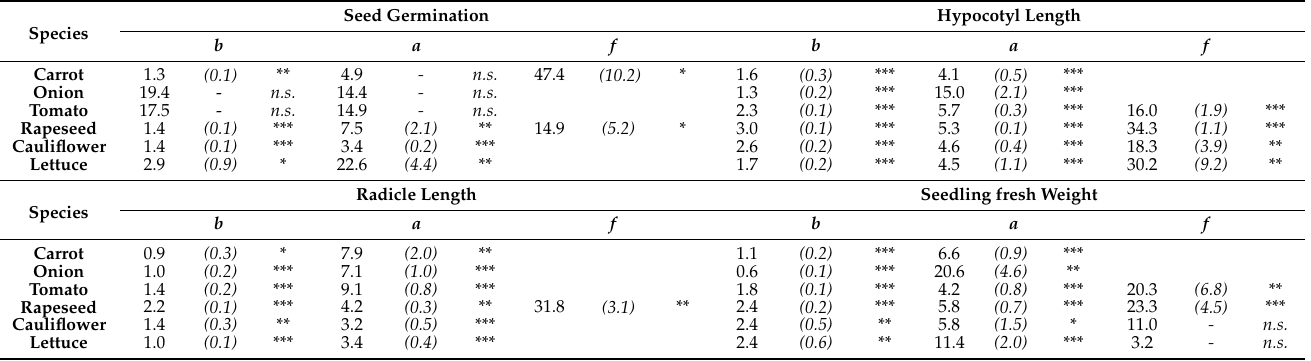
Table 1. Dose–response curve parameters ( b , a and f ) calculated from the fitted equations in Figure 1. Standard errors are in parentheses (not significant: n.s.; significant: * p = 0.05, ** p = 0.01, *** p =